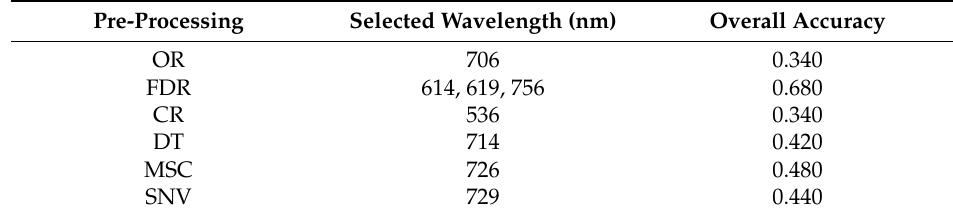
Table 2. E ff ective wavelength to distinguish the pH conditions based on stepwise discriminant analysis ( p < 0.001).